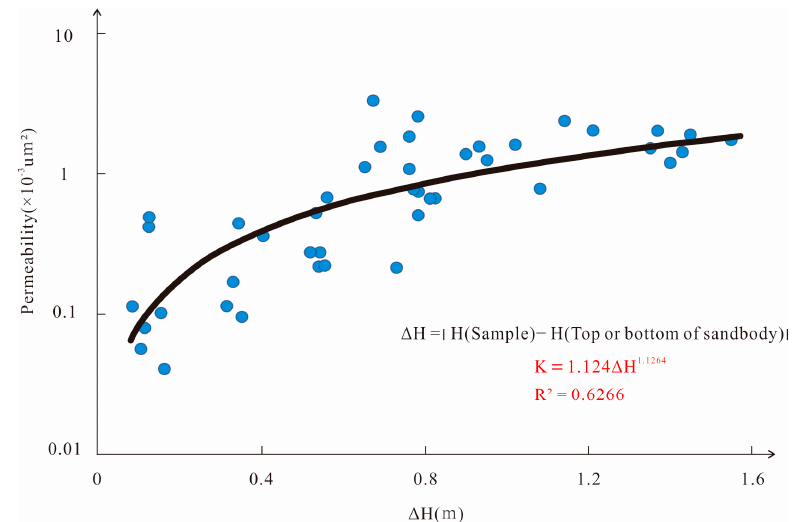
Figure 8. Relationship between sandbody thickness and permeability.